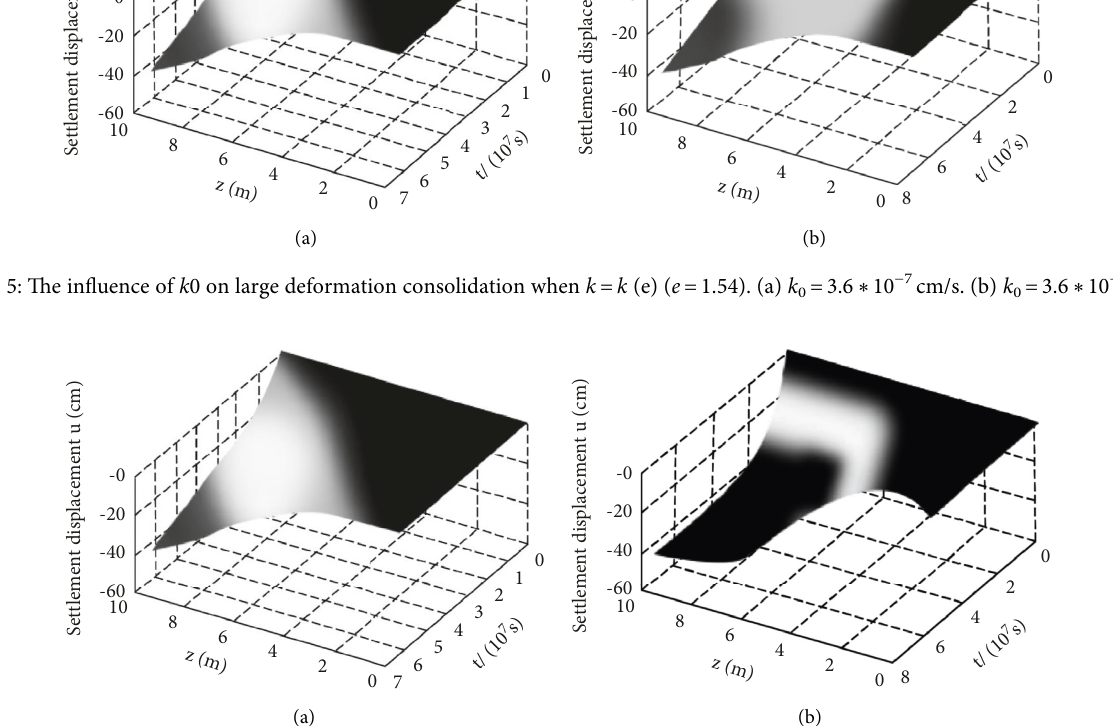
� e � 3.6 ∗ 10 − 7 cm/s. (b) k 0 , e 0 ). (a) k 0